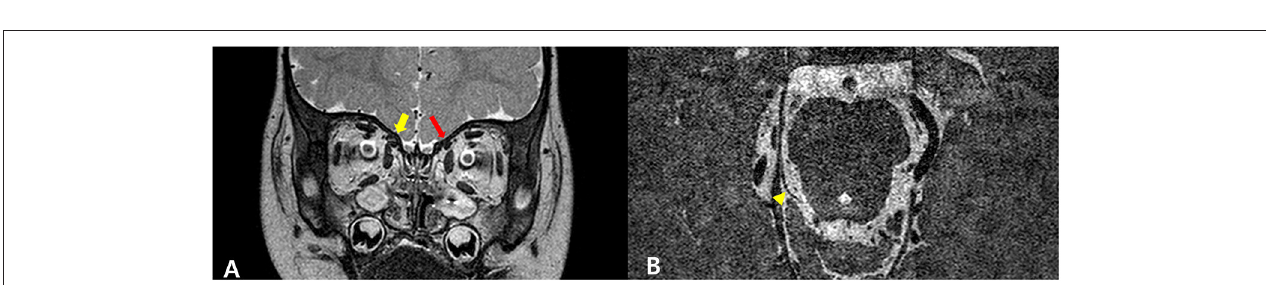
FIGURE 3 | Ultrasonography of the right (yellow arrow) and left sternocleidomastoid muscles (arrowhead), revealing a fibromatosis colli in the right sternocleidomastoid, suggesting right CMT at the age of 3 months (A) . A follow-up test at the age of 7 months showed the decreased size and improved echogenicity in the right sternocleidomastoid (B) .